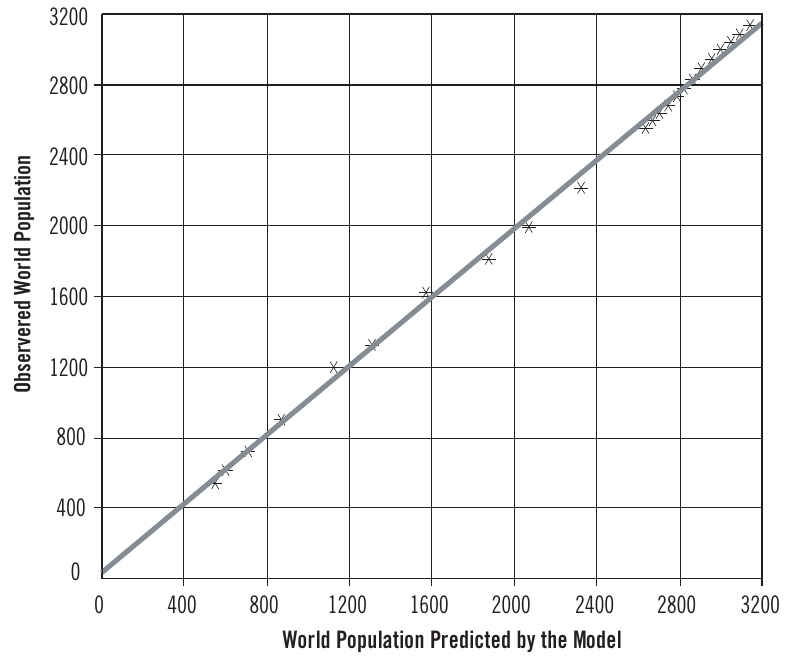
Figure 2 – Correlation Between Predicted and Observed Values